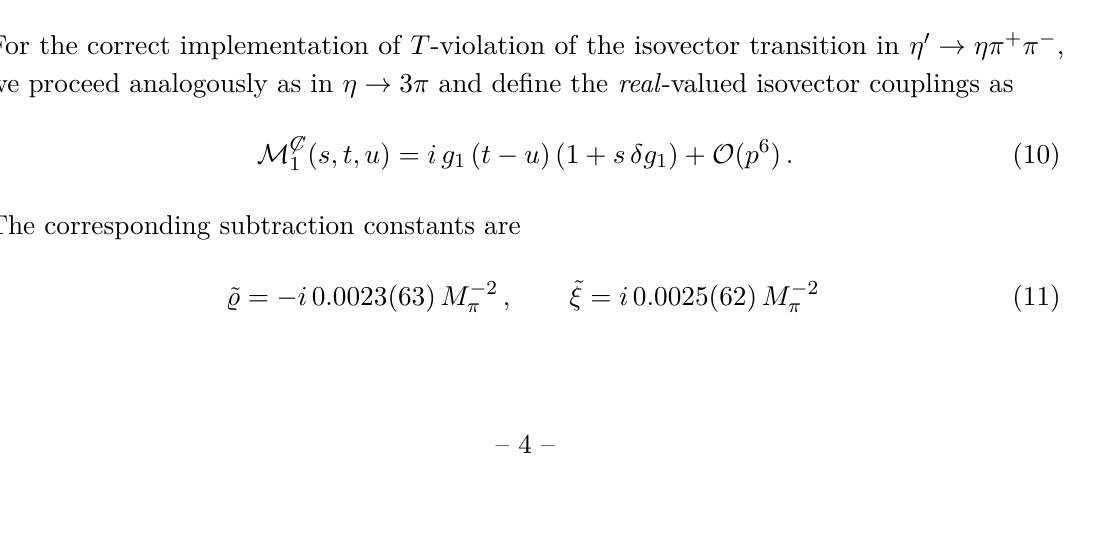
Figure 2 . Estimation for the distribution of the real (left) and imaginary (right) parts of 6 C π + π − π 0 over the allowed phase space. This is the corrected version of and (bottom) in η 0 2 M → figure 6 in ref.